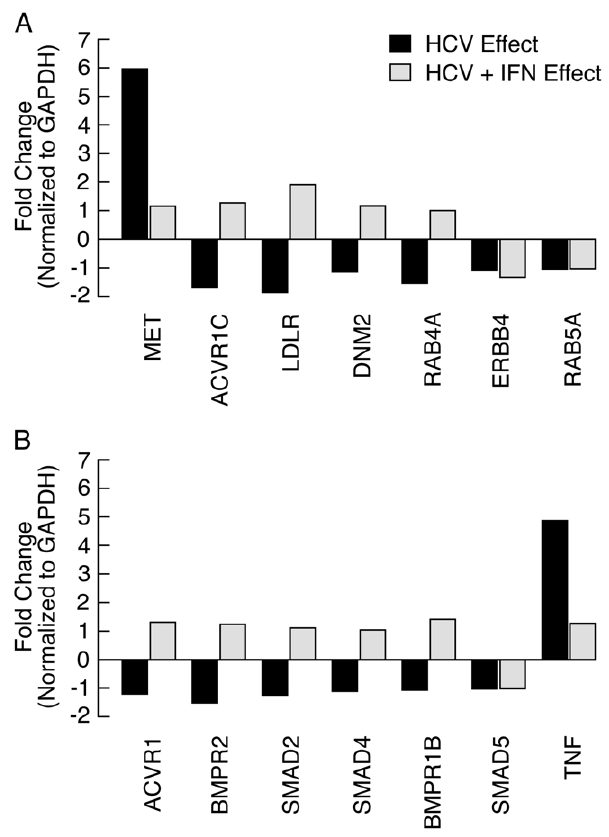
Figure 4. Expression of mRNA targets of miR-130a/301 in HCV- infected Huh7.5 treated with IFN- a . The top seven highly predicted mRNAs of gene targets for miR-130a/301 found in the endocytosis pathway (A) and TGF- b signaling pathways (B) were tested for expression using real-time quantitative RT-PCR and HCV-infected Huh7.5 cells without IFN- a (HCV effect) and with IFN- a (HCV + IFN effect). The fold change in gene expression is normalized to GAPDH.